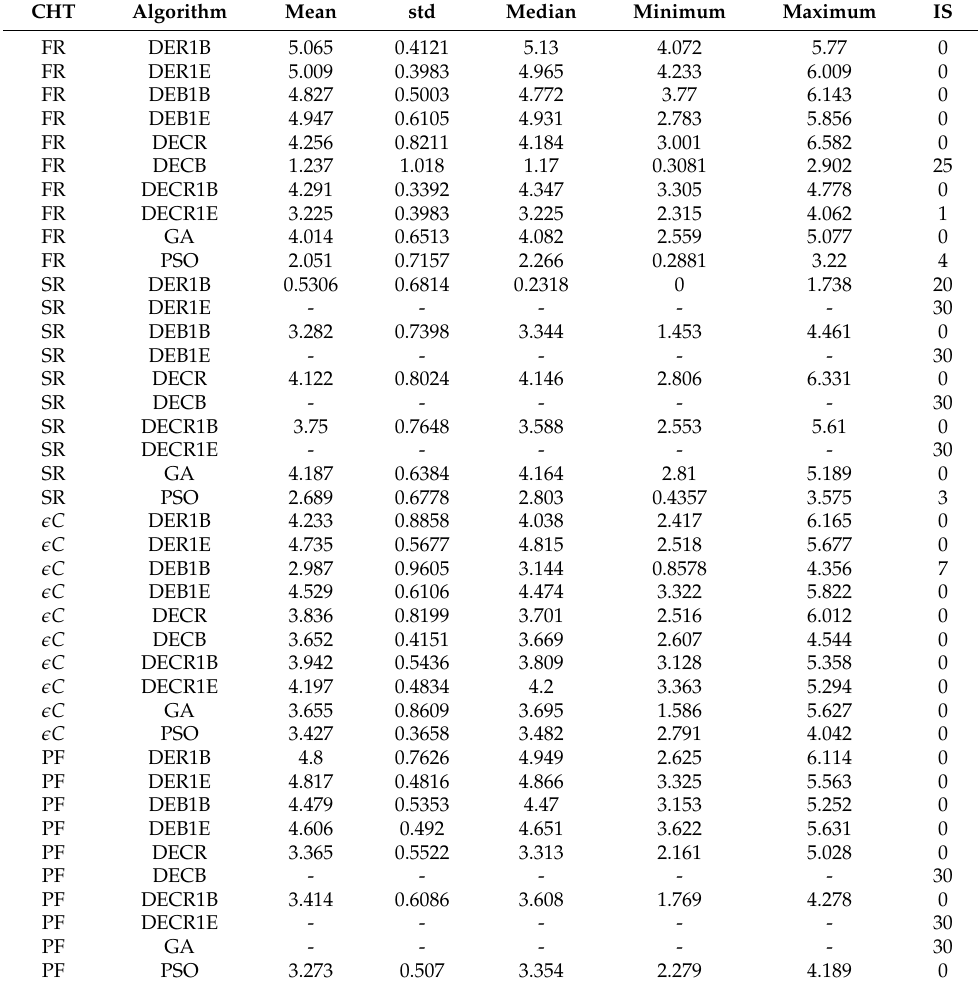
Table A23. PR descriptive statistics for study case 3: Eight-bar linkage mechanism. IS means the number of infeasible solutions through the executions. “-” indicates that it is not possible to compute such a